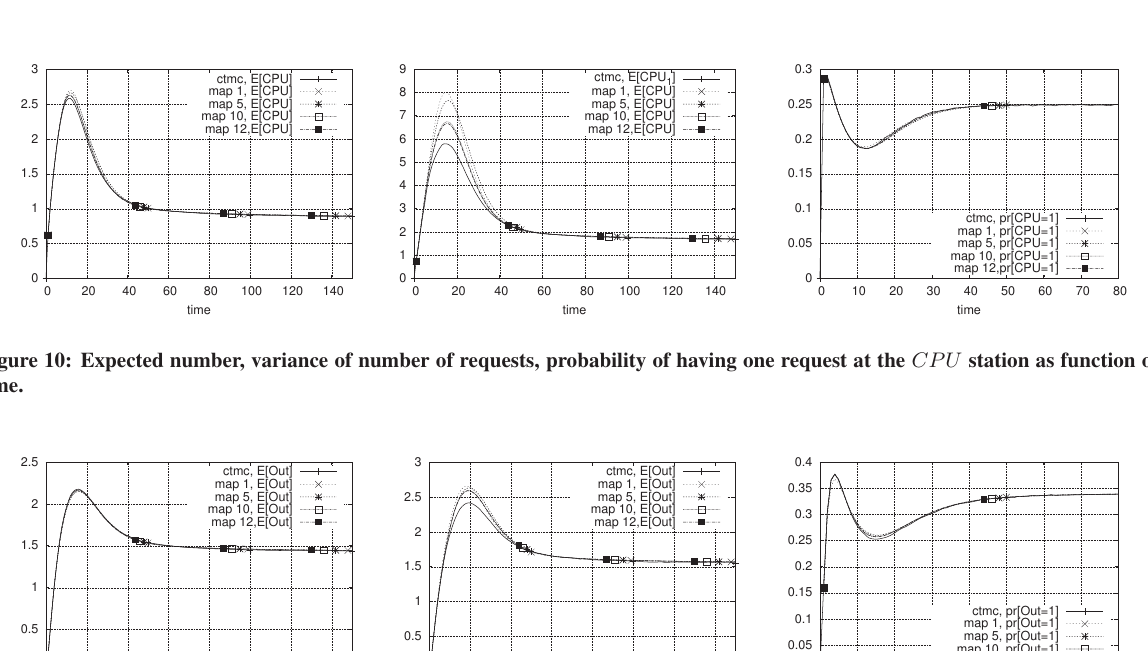
Figure 9: Expected number, variance of number of requests, probability of having one request at the Out station as function of time.